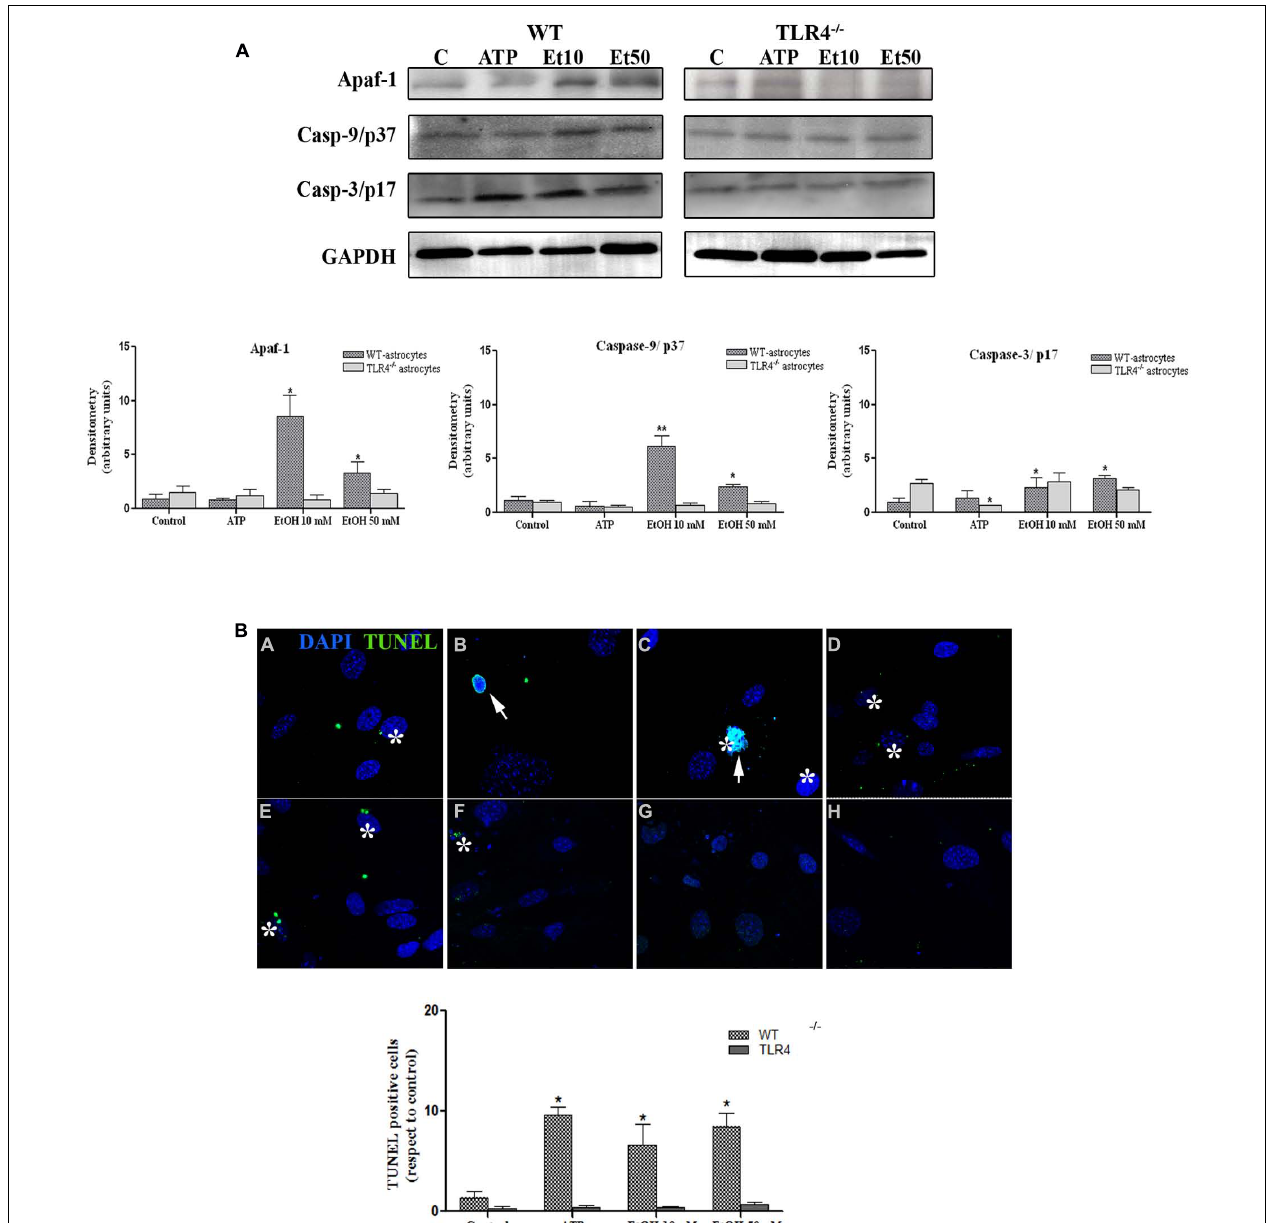
FIGURE 8 | Ethanol can also induce the apoptosome formation in astrocytes. (A) The Western blot analyses of Apaf-1, the active fragments from caspase-9 (37 kDa) and caspase-3 (17 kDa), in the astrocytes treated with ATP (5 μ M) or ethanol (10 and 50 mM). Bars represent the (mean ± SEM) of at least 6–10 individual experiments. * p < 0.05, ** p < 0.01 (Mann–Whitney U non-parametric test or a Student’s t -test). (B) The percentage of apoptosis in the astrocytes